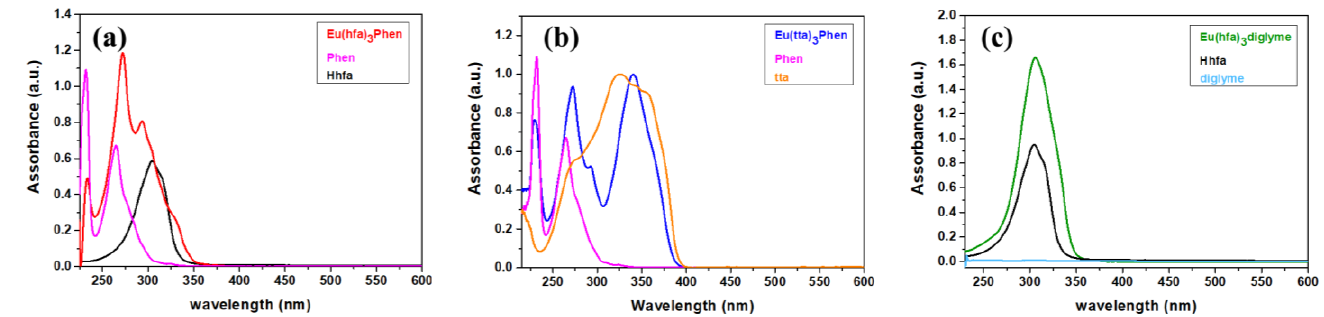
Figure 3. UV-vis spectra comparison of ( a ) [Eu(hfa) 3 (phen)], ( b ) [Eu(tta) 3 (phen)] and ( c ) [Eu(hfa) 3 (diglyme)] complexes with the corresponding ligands (1 × 10 − 4 M CH 2 Cl 2 ).